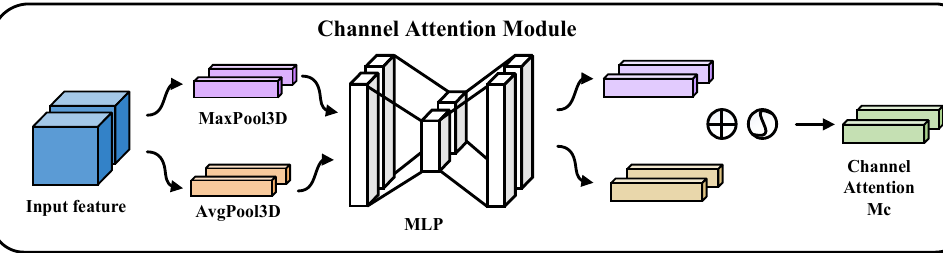
Figure 4. Channel attention module.